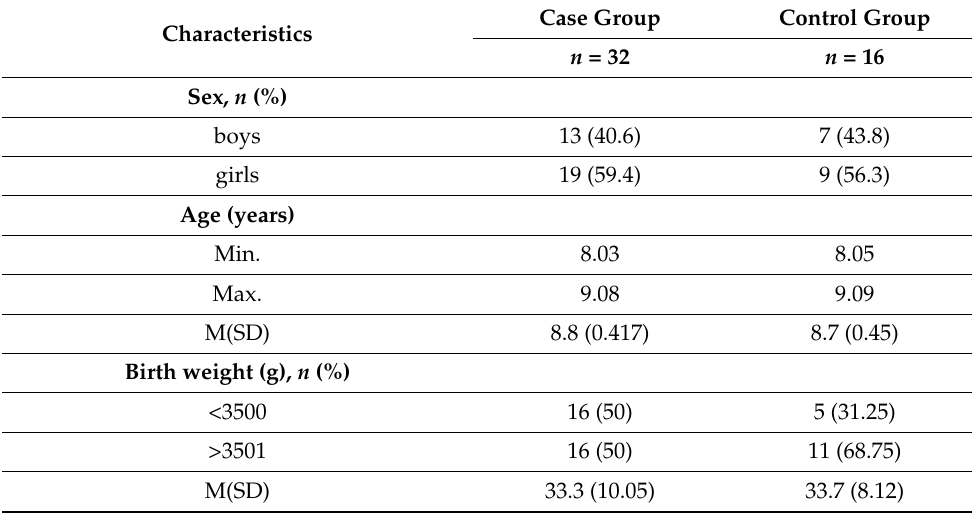
Figure 1. The structure of the study. HIE—hypoxic-ischemic encephalopathy. Table 1. Children’s characteristics.